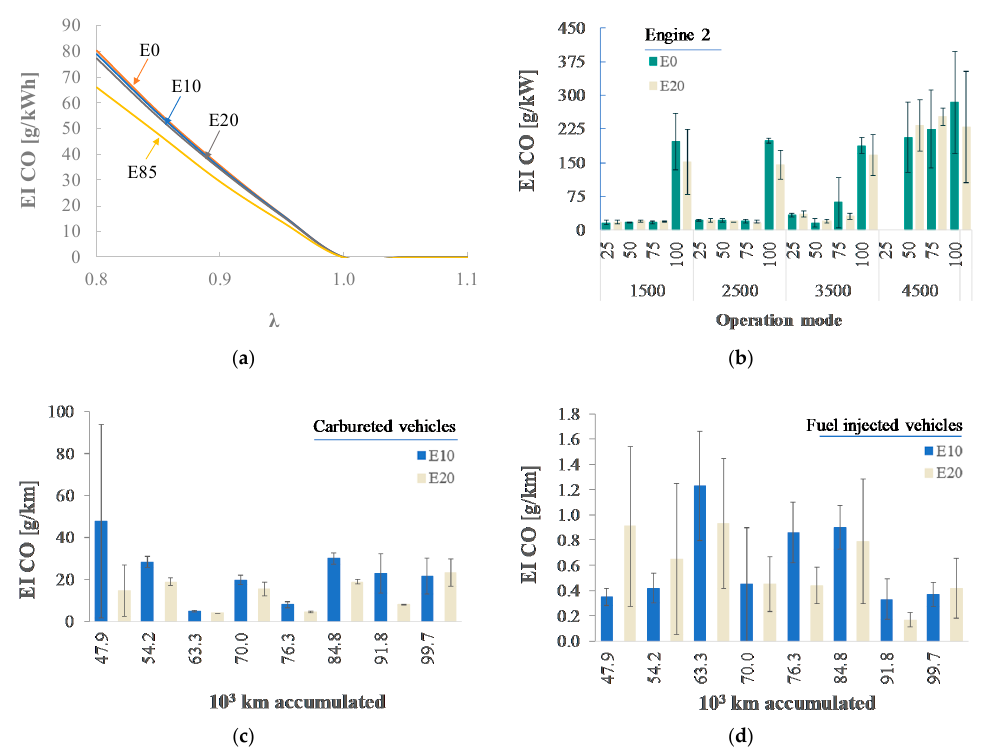
Figure 6. CO emission indexes obtained by: ( a ) Our analytical model for engines; ( b ) Engine tests under steady-state condition; ( c ) Carbureted and ( d ) Fuel-injected vehicles following the NEDC on chassis dynamometers, after every 10,000 km traveled .